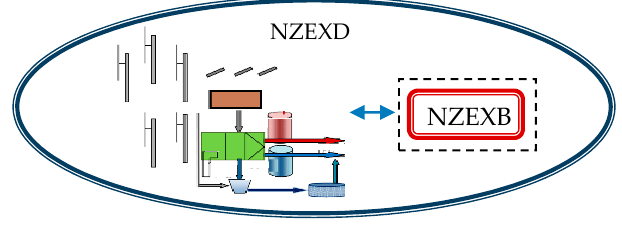
Figure 3. NZEXD and NZEXB Targets.